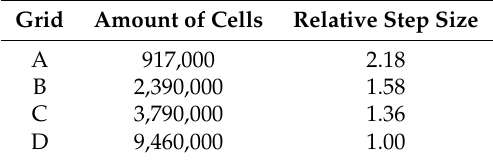
Table 6. Amount of cells and relative step size for different